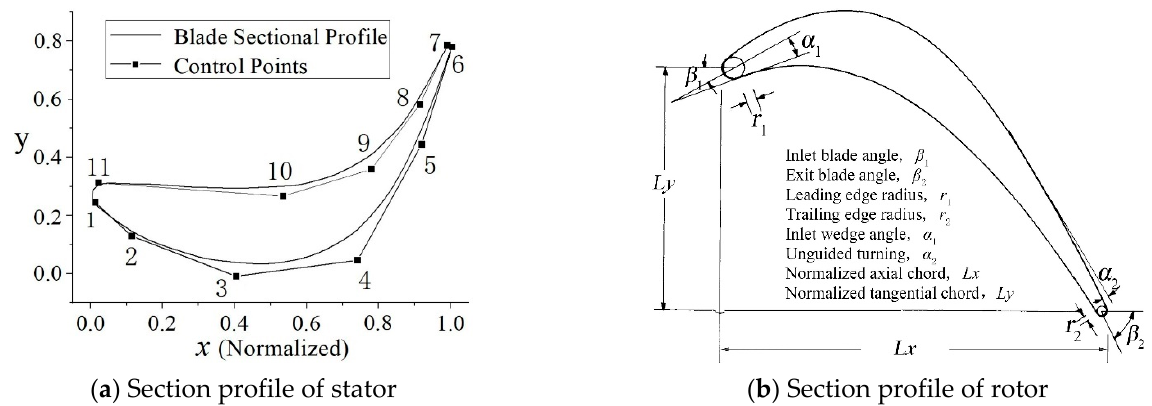
Figure 11. Parameterization of stator and rotor sectional profiles. Rotor